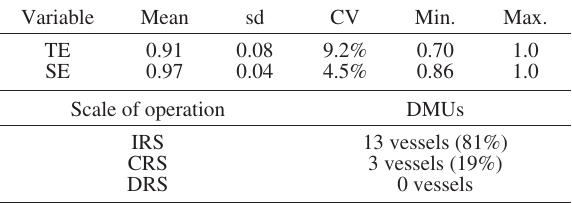
Table 6. – Descriptive statistics of technical efficiency (TE), scale efficiency (SE) and scale of operation for the mixed strategy (60%- 80%). N=16. IRS, increasing returns to scale; CRS, constant returns to scale; DRS, decreasing returns to scale.